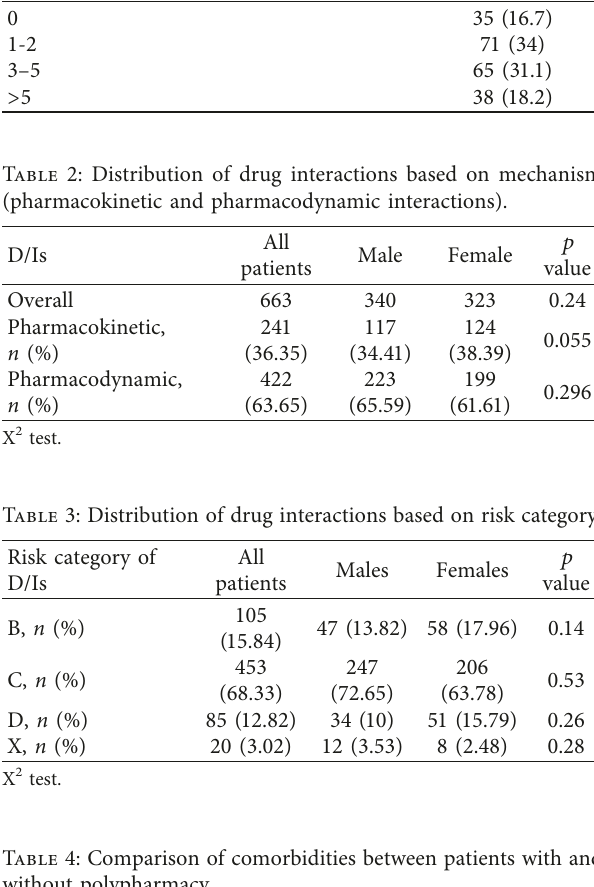
Table 1: Number of drug interactions among all patients. Number of drug interactions All patients, n (%)